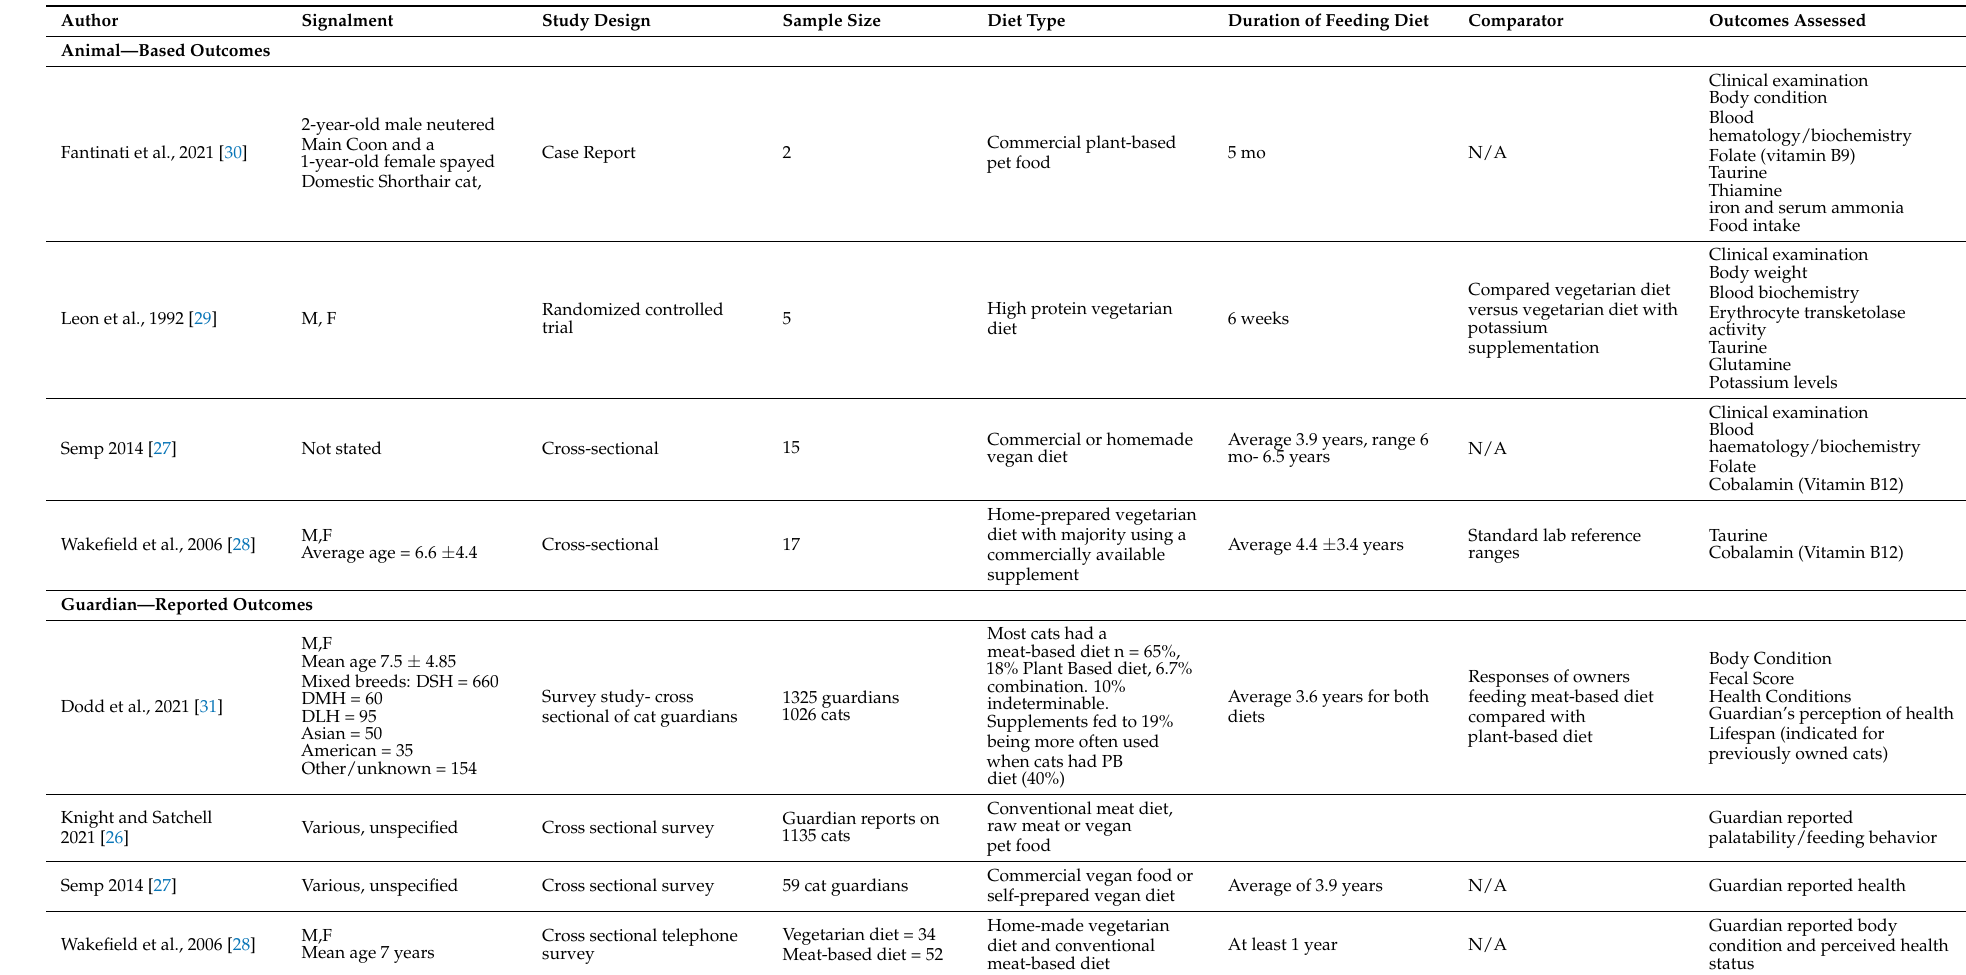
Table 1. Characteristics of studies evaluating vegan diets in